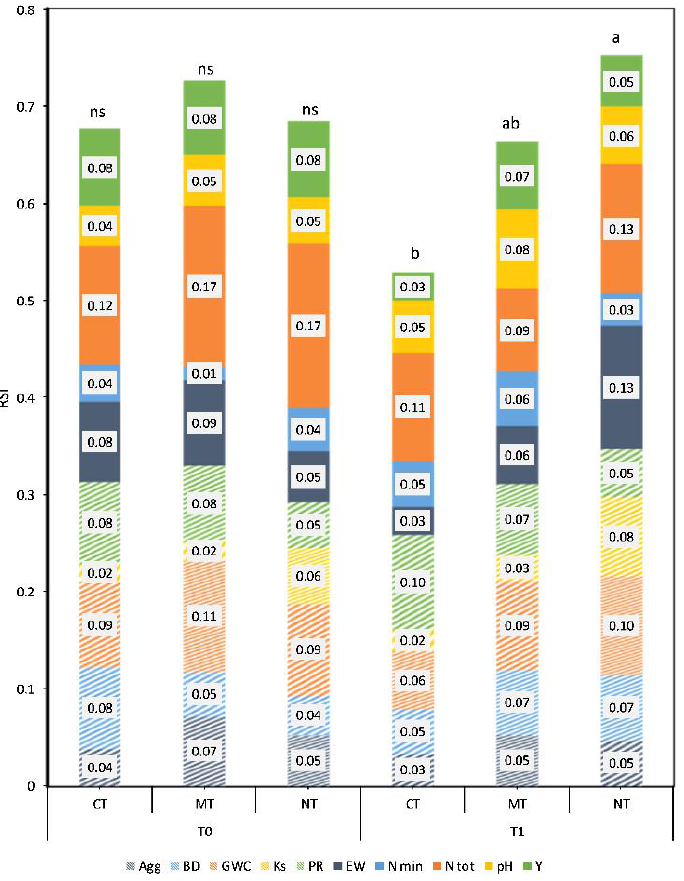
Table 6. Linear mixed model analysis of RSI output.